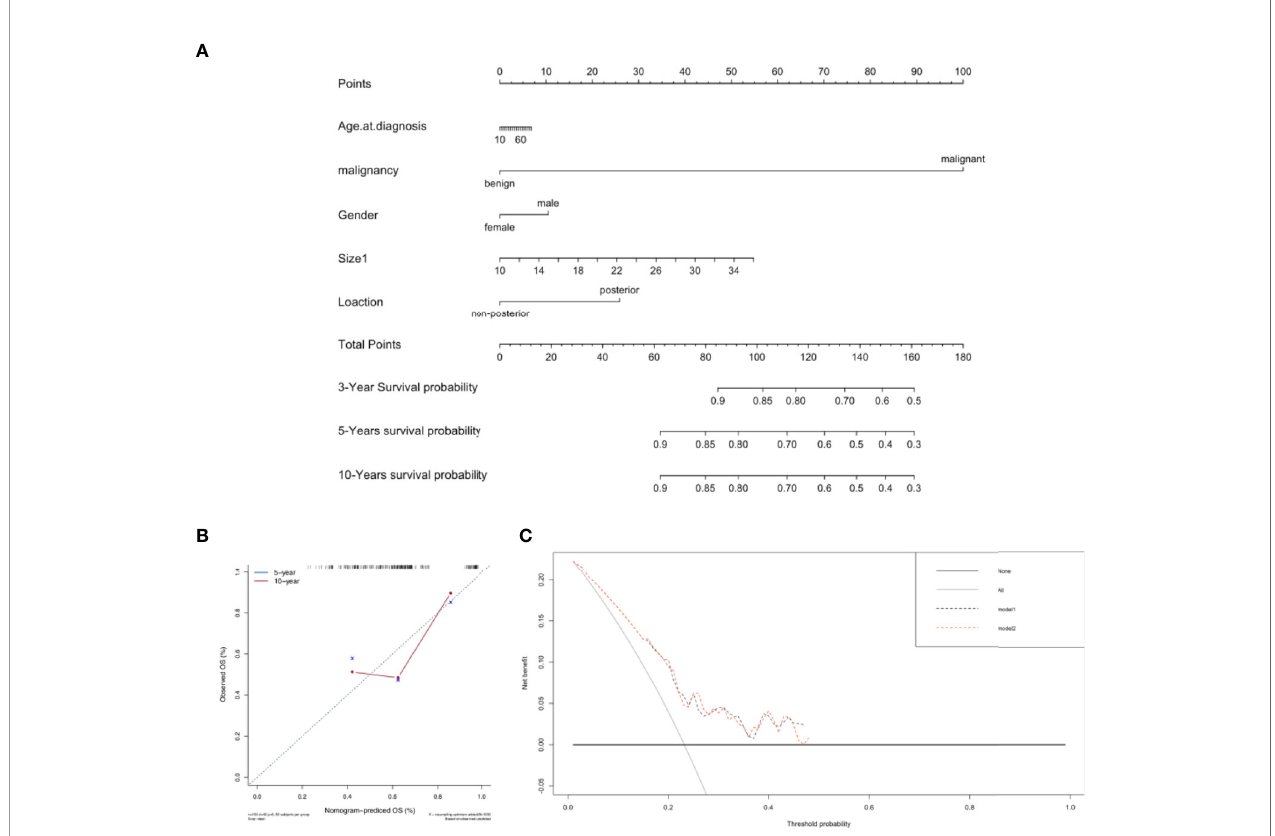
FIGURE 4 | Predictive model for postoperative survival in patients with GMTs who underwent complete resection. (A) Postoperative prognostic nomogram for patients with resected GMTs. (B) Calibration curves for predicting 5-year and 10-year survival. (C) Evaluation of the prediction model by decision-curve